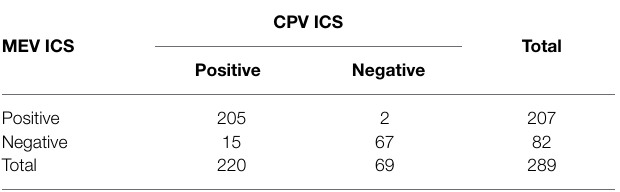
TABLE 1 | Comparison of the sensitivity and specificity of the mink enteritis virus (MEV) immunochromatographic strip (ICS) and canine parvovirus